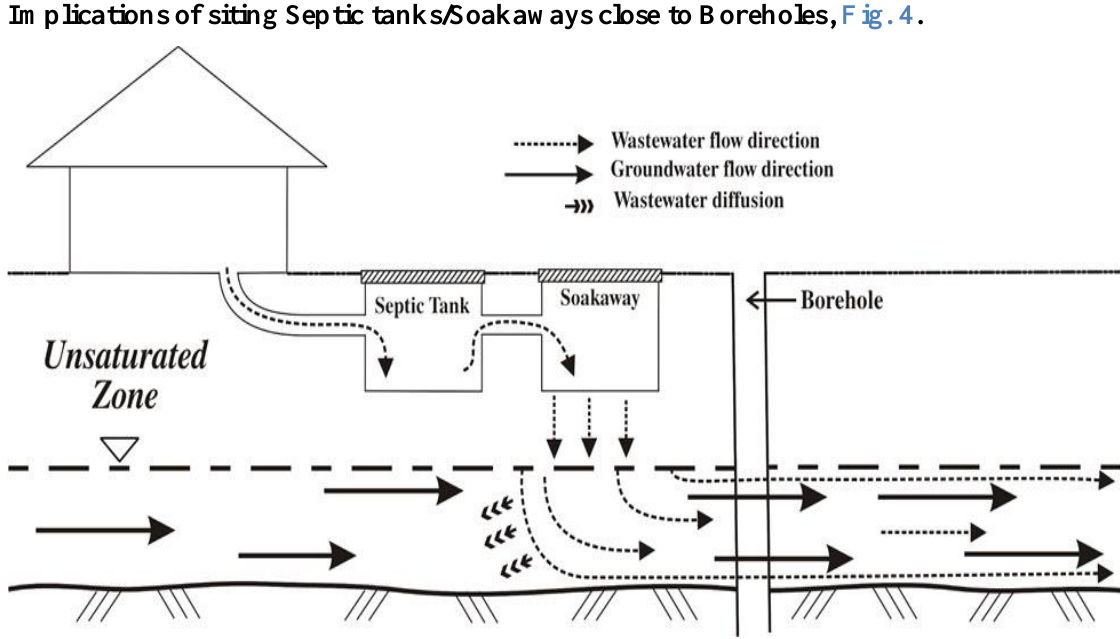
Fig. 4. Representation of the effects of Septic tank and Soakaway pit on ground water (Eze & Evelyn